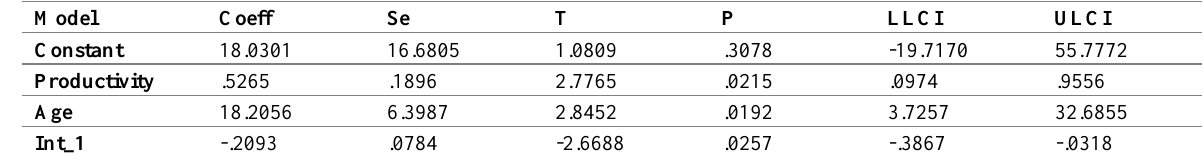
Table 10: Results of Moderation Effect Using Hayes Process Macro (Model 1)